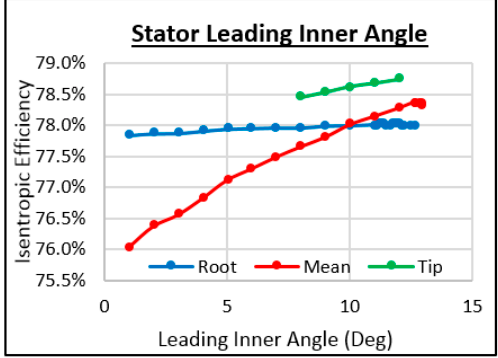
Figure 21. Study of the stator leading inner angle.